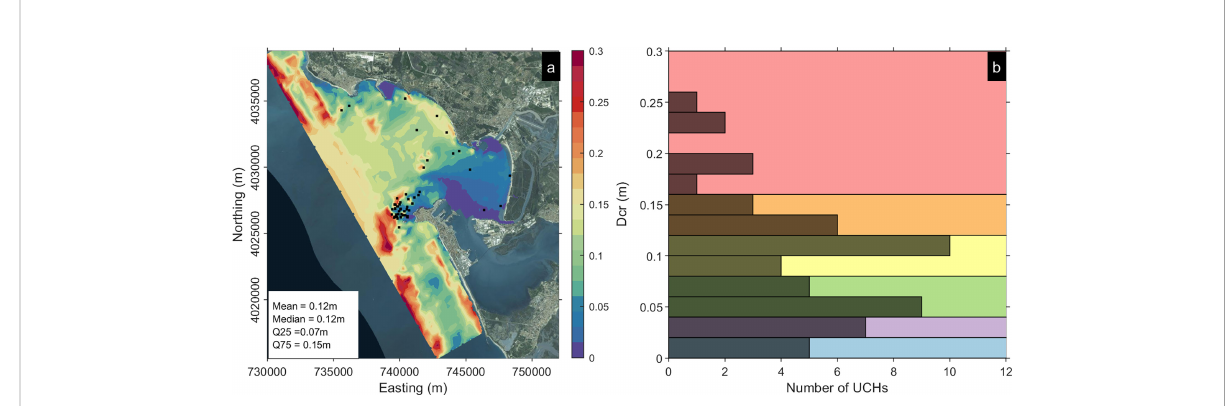
FIGURE 4 (A) Map of decontextualization hazard (critical diameter moved under wave action) in the outer Bay of Cadiz [black dots mark the position of the underwater cultural heritage (UCH) sites]. (B) Histogram of the hazard at UCH sites and hazard classes (background